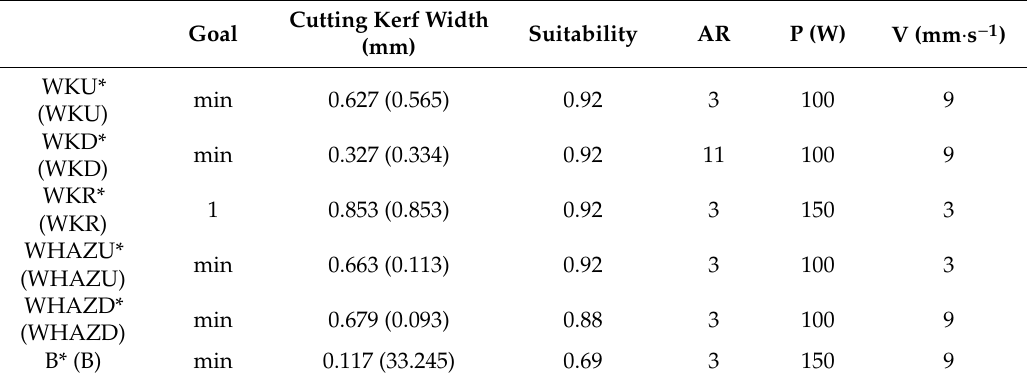
Table 7. Results of separate optimization of the investigated factor